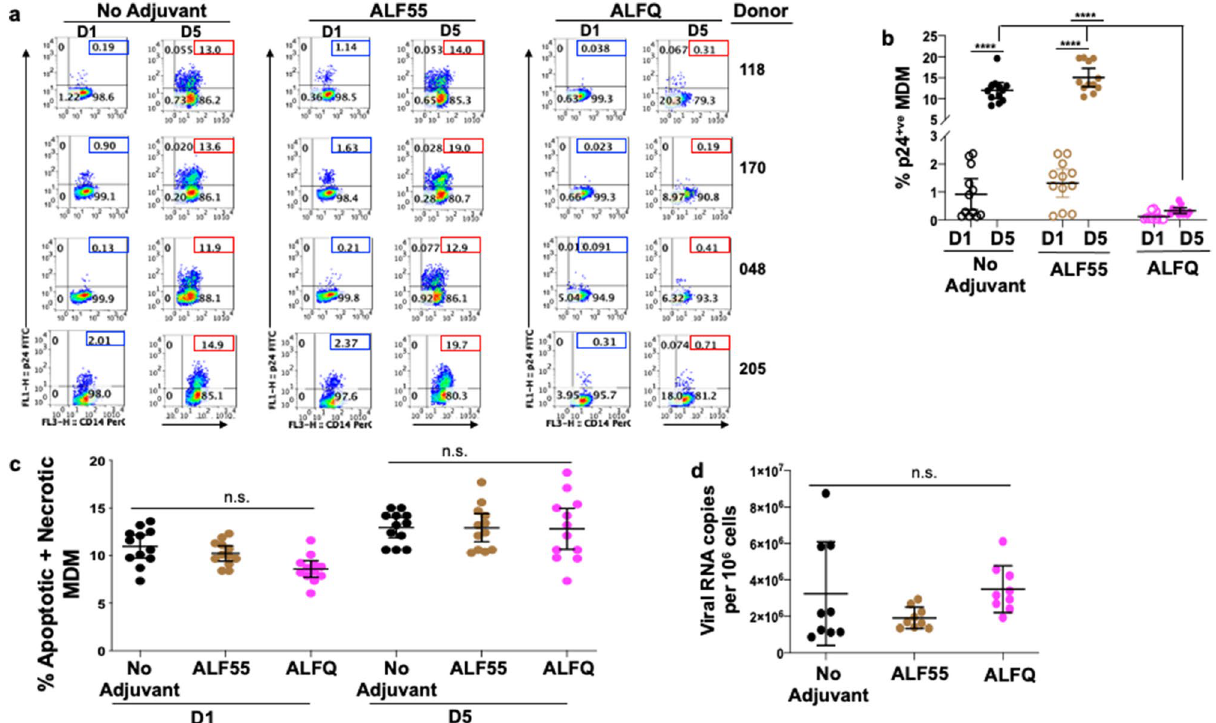
Figure 6. HIV-1 infection is restricted in ALFQ-treated MDM. Primary human monocytes were differentiated into MDM following in vitro culture with M-CSF media. At day 4 post-culture, the cells were pre-treated with ALF55 or ALFQ for 24 h. Untreated MDM (no adjuvant) cultures served as controls. Cells were washed and infected with US-1 (4 ng p24). Cultures were harvested at day 1 and day 5 post-infection (p.i) and analyzed for the presence of intracellular p24 by flow cytometry. ( a ) Values (blue boxes, day 1 p.i; red boxes, day 5 p.i) in the upper right quadrant(s) of the plots represent the percentage of HIV-1-infected MDM under each treatment. ( b ) Scatter dot plots (open circles, day 1 p.i; filled circles, day 5 p.i) represent the data from triplicate wells of 4 donors and show the percentage of HIV-1-infected MDM (mean ± s.d.) in untreated (no adjuvant) MDM (black circles), MDM treated with ALF55 (brown circles) or with ALFQ (magenta circles). Statistical difference between the treatments was determined by One-way ANOVA. Statistically significant differences between % of infected cells at day 1 and day 5 p.i for each of the treatments as well as differences in % of infected cells between ALF55- and ALFQ-treated MDM at day 5 p.i. are shown. **** P < 0.0001. ( c ) Scatter dot plots show the percentage (mean ± s.d.) of apoptotic and necrotic MDM in the untreated cultures (black circles), cultures treated with ALF55 (brown circles) or ALFQ (magenta circles) at day 1 and day 5 post-infection of triplicate wells of four donors. Two independent experiments were conducted. The percentage (mean ± s.d.) of apoptotic and necrotic MDM was compared between the groups by One-way ANOVA and were not statistically different (n.s.) at each time-point. ( d ) Scatter dot plots represent the amount of captured virus and show the amount of HIV-1 RNA per 10 6 MDM (mean ± s.d.) in untreated (no adjuvant) MDM (black circles), MDM treated with ALF55 (brown circles) or with ALFQ (magenta circles). of triplicate wells of three donors. The groups were compared by One-way ANOVA and were not statistically